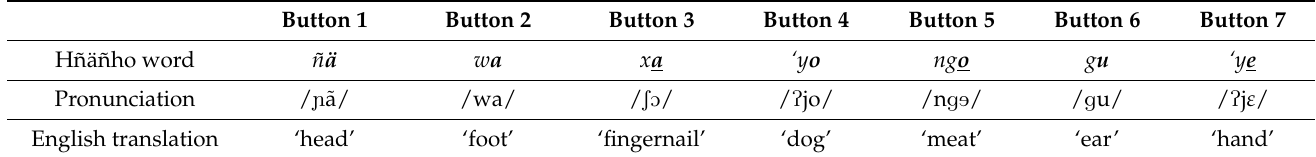
Table 1. The Response Pad visual aid in Hñäñho for the HHS group.